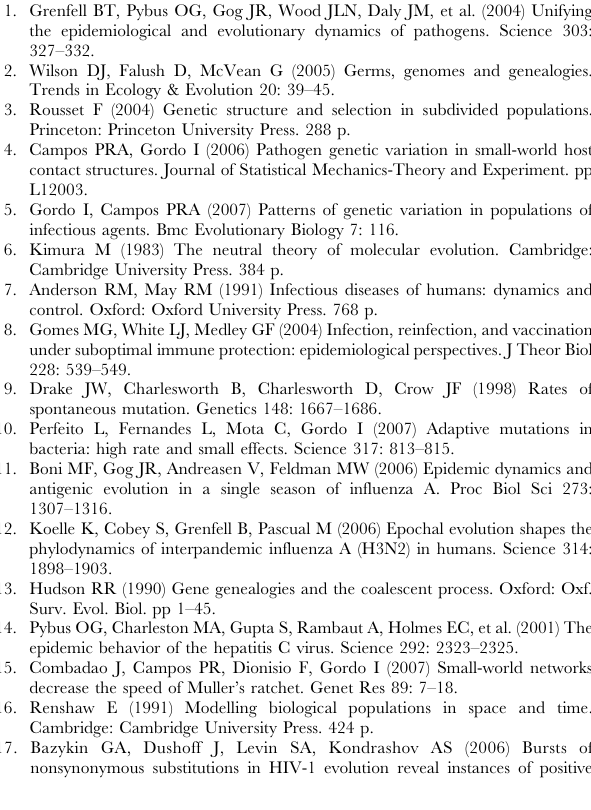
Figure S3 Time plot of the pattern of diversity during the replacement of a new strain. On the left scale of the plot diversity (gray line) and Tajima’s D (filled triangles). On the right scale we plot the total frequency of infection (dashed line) and the frequency of hosts infected with new selected strain (filled line). Parameters are as follows: D= 30000, initial R0 =4, U= 0.00005, dc= 2 e =0.1, E =0.7, e1 = 0.3, e2 = 0.7 and b = 0.005. Found at: doi:10.1371/journal.pone.0004876.s003 (0.04 MB TIF) Text S1 Supporting sequence